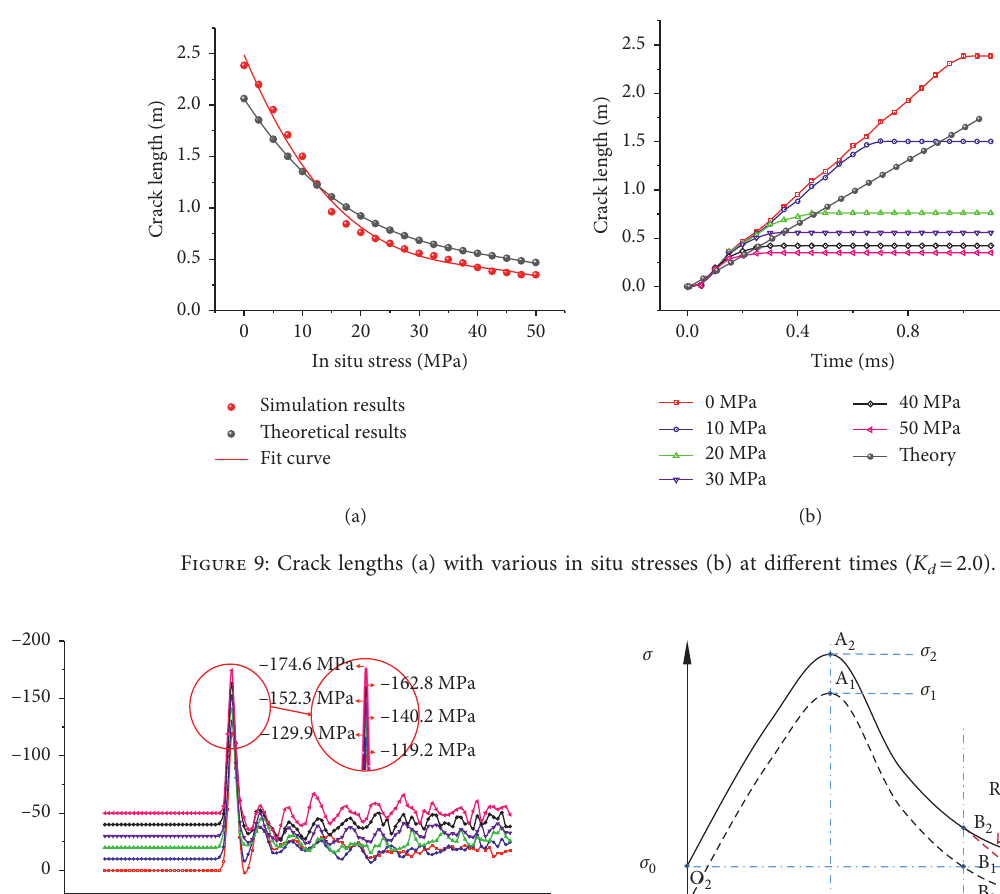
0.0 Figure 10: Time-history curves of radial stress at point C under different hydrostatic pressures.